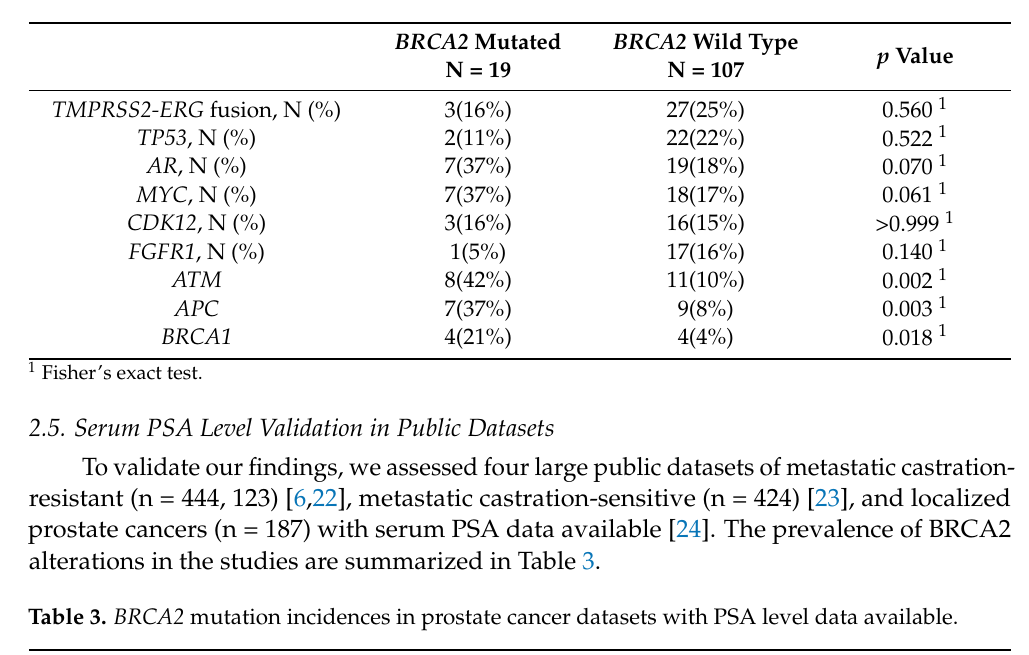
Table 2. Genomic Characteristics of BRCA2 mutated cancers.